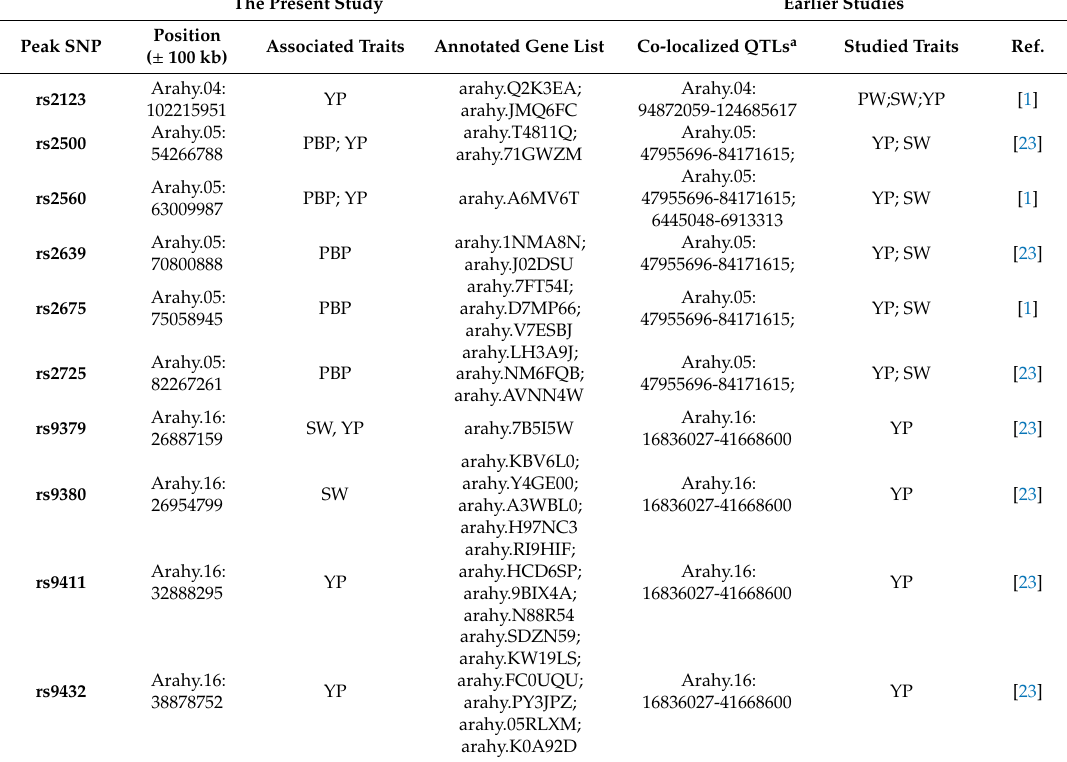
Table 2. A summary of the genomic regions that are co-localized with earlier identified QTLs.